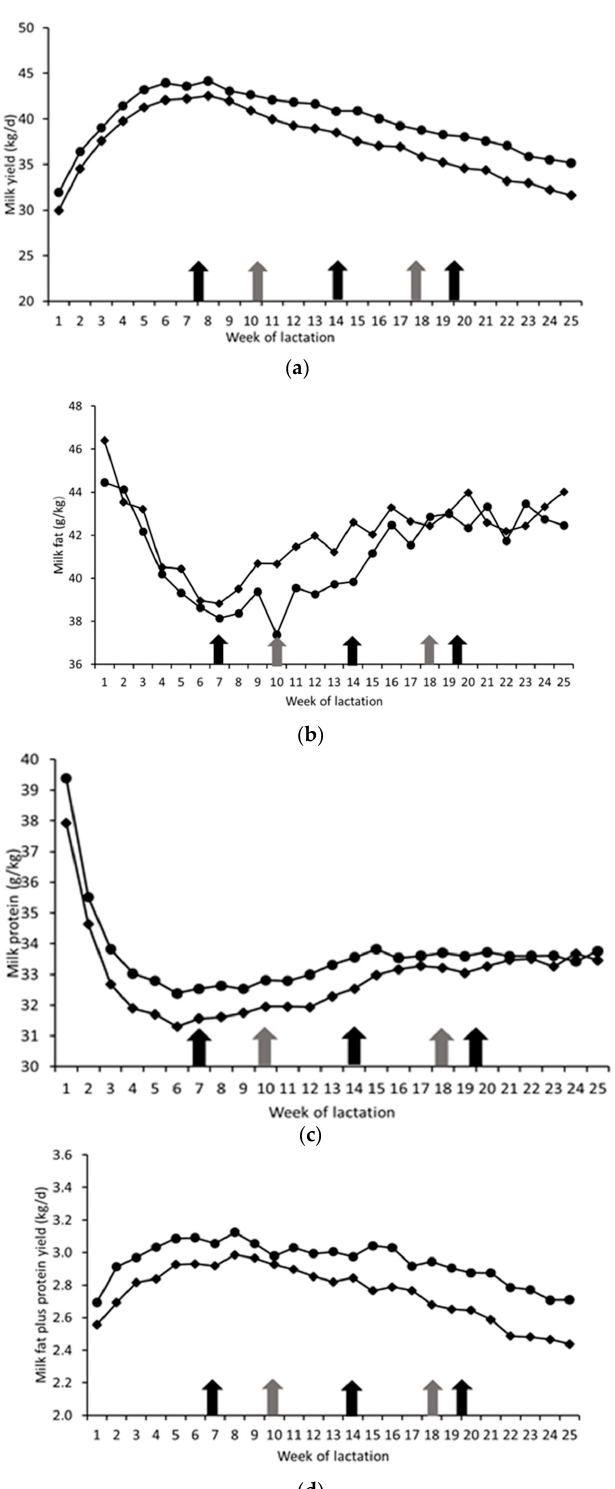
Table 3). Milk yield, milk fat content, milk protien content and milk fat plus protein yield varied ( p > 0.001) over the experimental period (Figure 2a–d, respectively). There were no interactions between treatment and week of lactation for any milk production parameter ( p < 0.05).